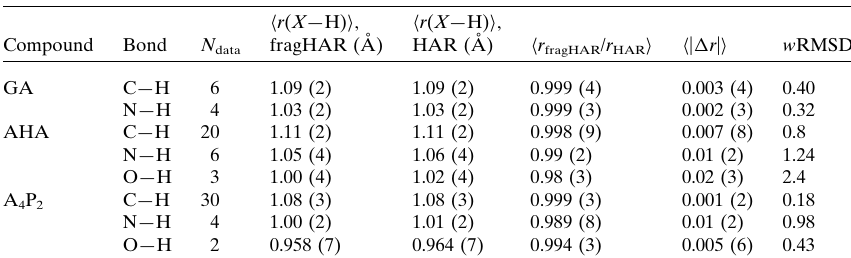
Table 2 Comparison of X —H bond lengths obtained with fragHAR and HAR. Values in parentheses represent the sample standard deviations. Compound Bond